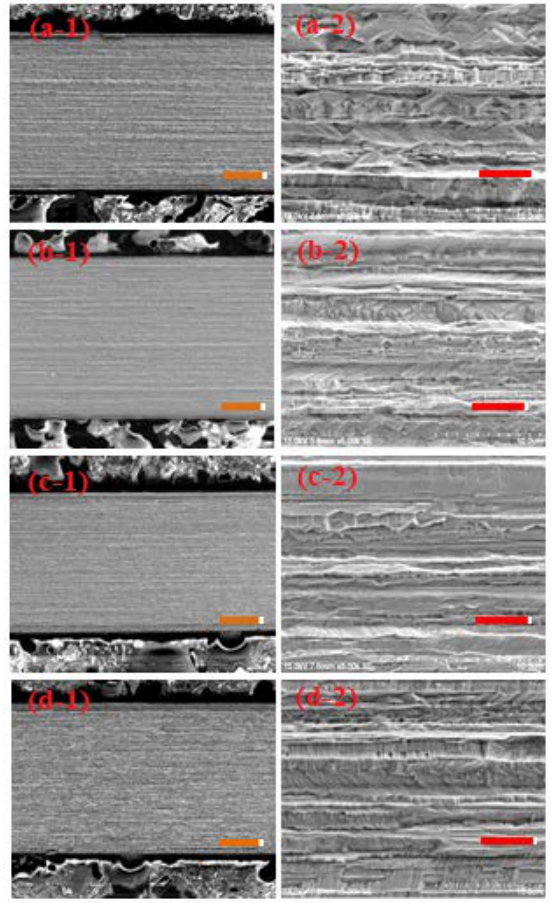
Figure 3. Microstructure of as-worked Φ 0.39 mm tungsten wires ( a ), ( b ), ( c ), and ( d ) are samples 1#-0, 1#-1, 2#-0, and 2#-1, respectively. Suffixes -1 and -2 mean global and local microstructures, respectively. Orange bars are 100 μm, and red bars are 5 μm.